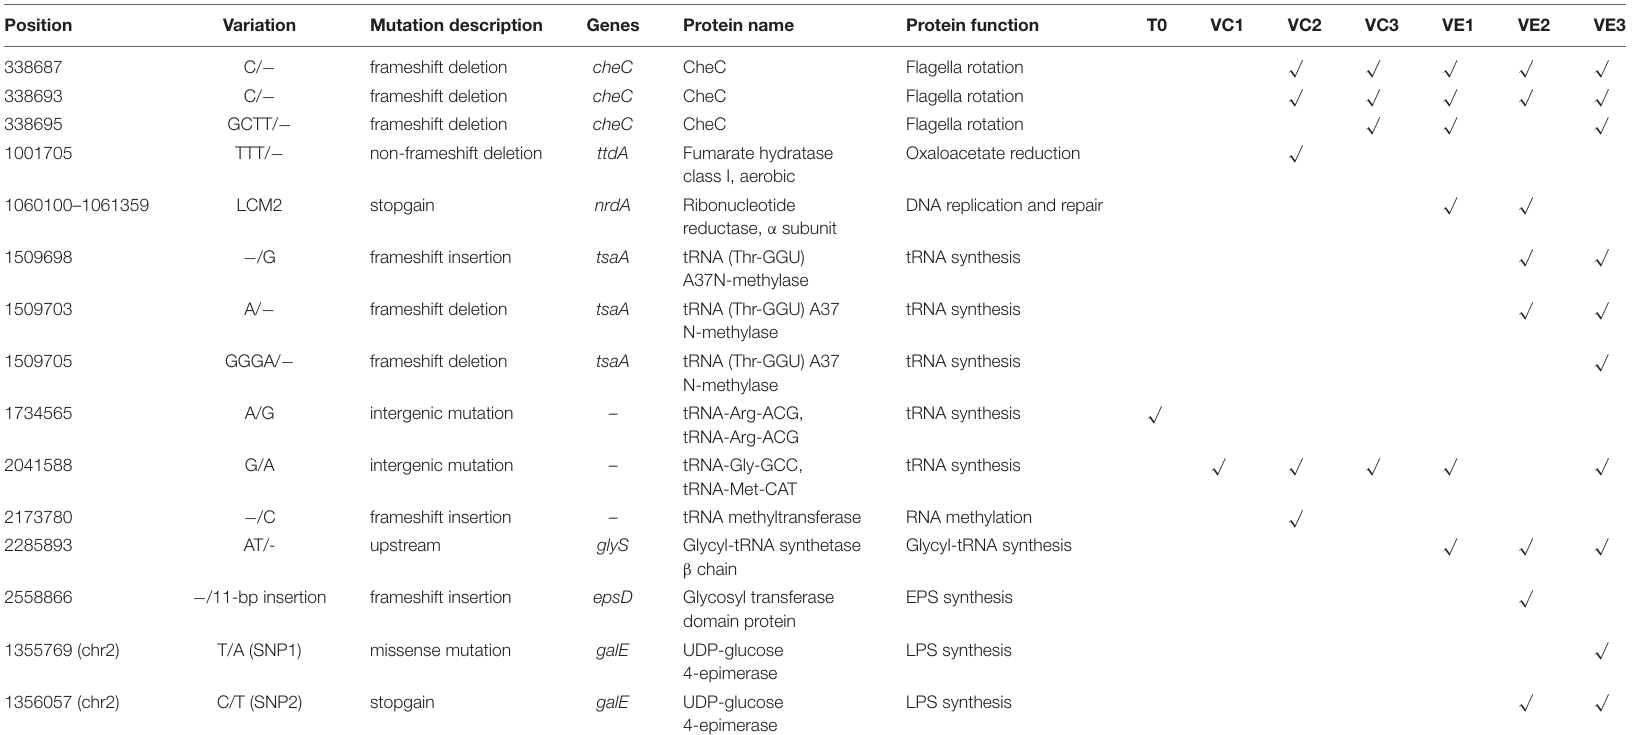
TABLE 3 | Mutant sites and related genes in evolved and coevolved V. alginolyticus cell populations. Position